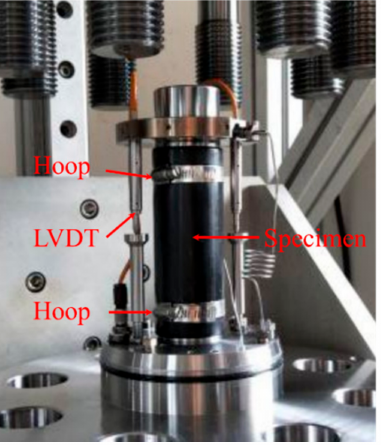
Figure 3. The static elasticity modulus